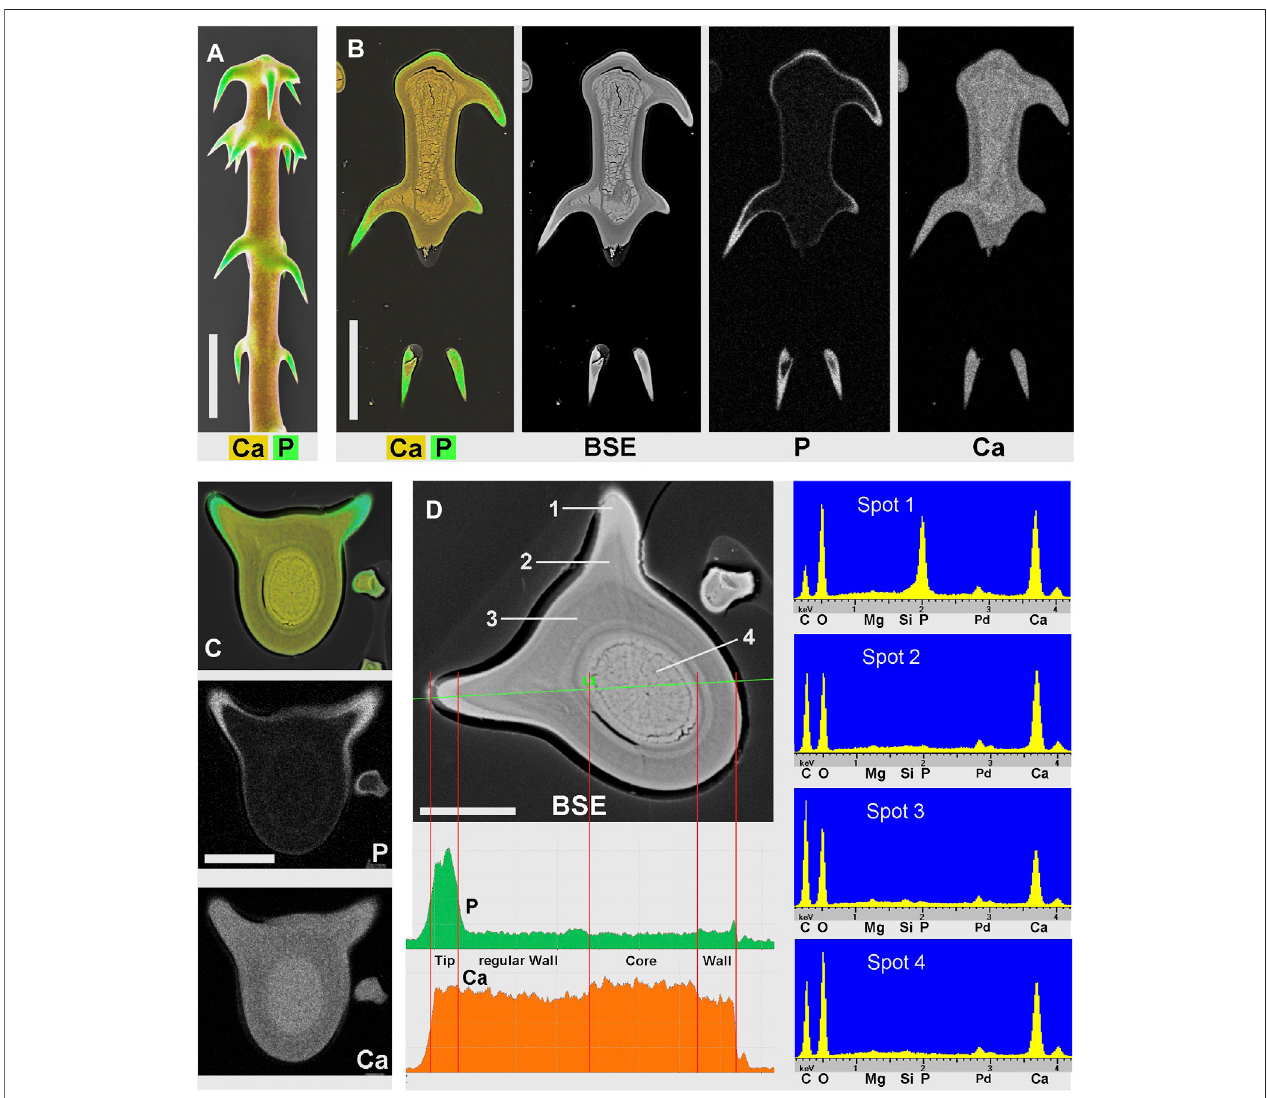
FIGURE5| Loasapallida ;element-mappingimagesandanalysesofglochidiatetrichomes.ColorsindicateCainyellowtobrown,Pingreen(togetherwithCa). (A) surface view; (B) longitudinal section through upper part of an embedded trichome. BSE image illustrates total mineral concentration with better resolution than EDX elementmapping.Pisfoundinthebarbtips,asanapicalcap,andasathinsurfacecoating, Caconcentrationsarehighestinbarbsandinner depositsandslightlylower in the wall of the shaft. (C – D) Analysis of a single trichome cross section shows Ca and P distribution in the element-mapping images (C) , whereas a BSE compositional contrast image (D) shows differentmineral concentrationsand strati fi cation due to higher resolution. EDX spectra ofselected spots and a line-scan show different Ca concentrations quantitatively. (Spots: 1 (cid:1) barb tip; 2 (cid:1) barb shoulder; 3 (cid:1) regular wall; 4 (cid:1) core.) Note the low carbon concentration in spectrum of Spot 1 from calcium phosphate-rich barb tip. Scale bars: A-B (cid:1) 50 μ m; C-D (cid:1) 20 µm.